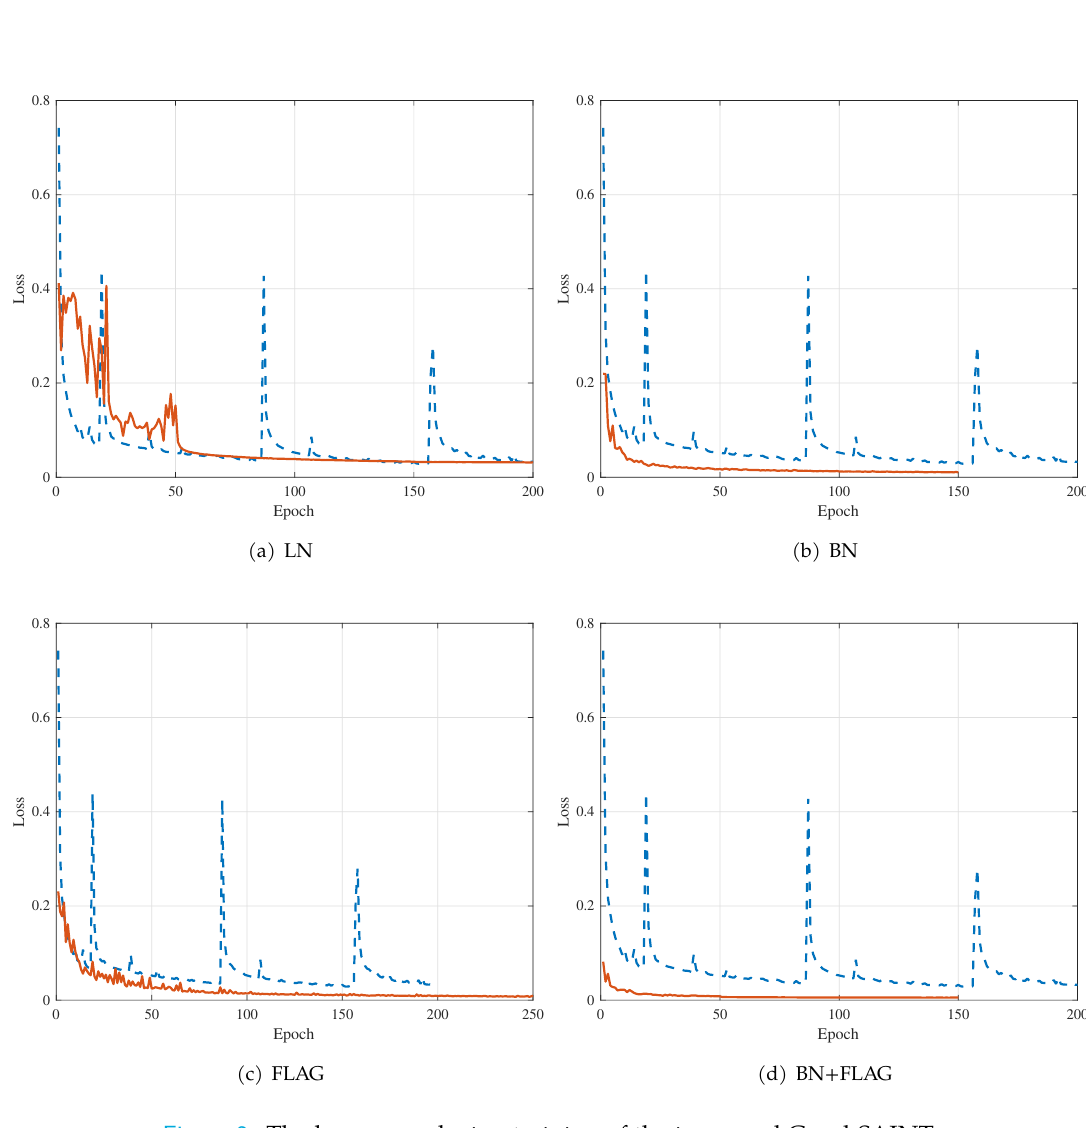
Figure 2: The loss curve during training of the improved